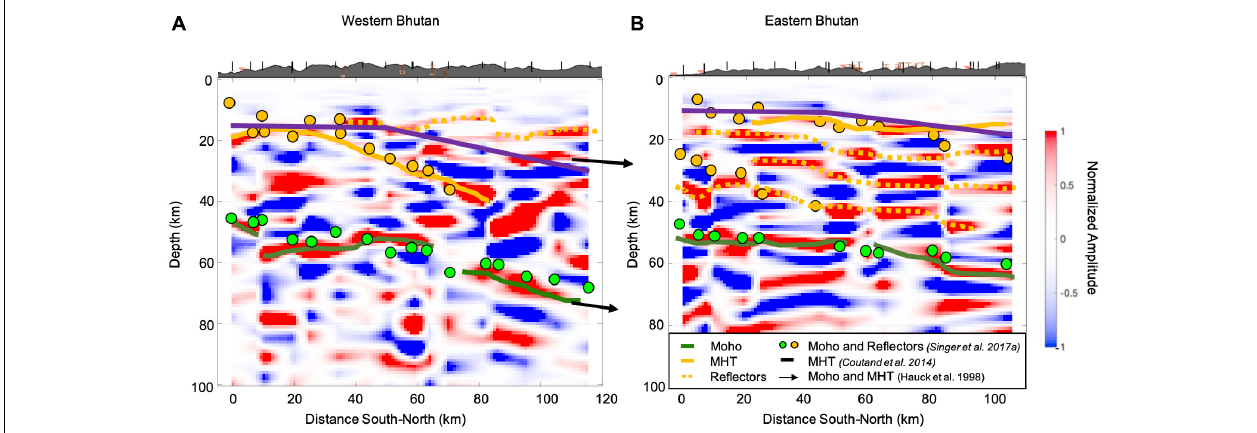
FIGURE 4 | First-order lithospheric structure across the orogenic wedge in Western (A) and Eastern (B) Bhutan from the depth converted GloPSI reflections. The thick green line indicates the interpreted Moho reflector, the solid orange line the Main Himalayan Thrust (MHT) and dotted orange lines indicate intra-crustal reflectors. The orange and green circles are the interpreted RF converters from Singer et al. (2017a) for crustal interfaces and Moho, respectively. The thick violet line indicates the approximate location of the MHT from multi-thermochronologic data interpreted by Coutand et al. (2014). The black arrows in Western Bhutan show the extrapolated dip of the MHT and Moho, as interpreted from the seismic reflection profile INDEPTH Tib-1 by Hauck et al. (1998). On top of both profiles, the topography is shown and the vertical ticks mark the stations location.